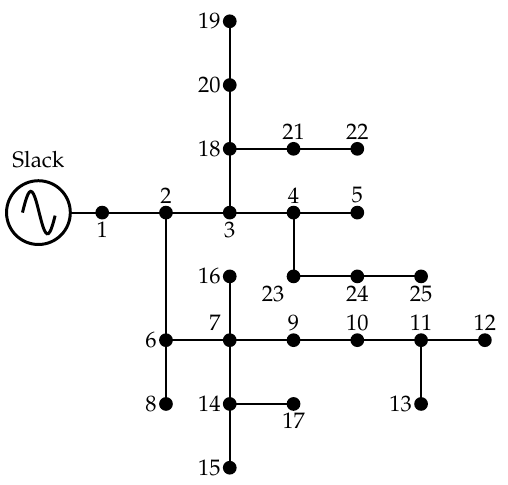
Figure 7. Electrical configuration of the 25-node